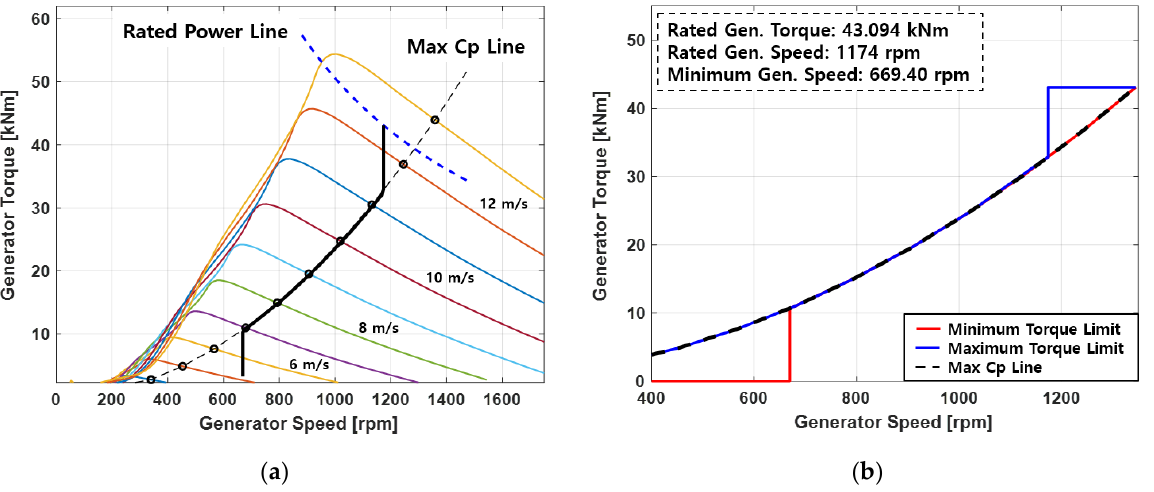
Figure 3. Strategy of MPPT control: ( a ) set-point of generator reaction torque; ( b ) generator reaction torque limiters.